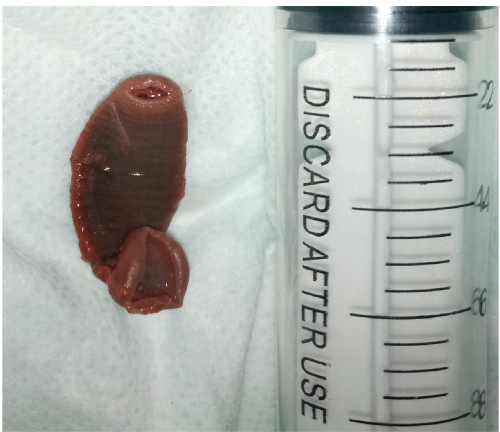
Figure 1: The leech removed from the nasopharyngeal area of our 5-year-old patient. Note: The head sucker and the posterior sucker are clearly visible. And the length can be estimated from the 10 cc syringe kept beside